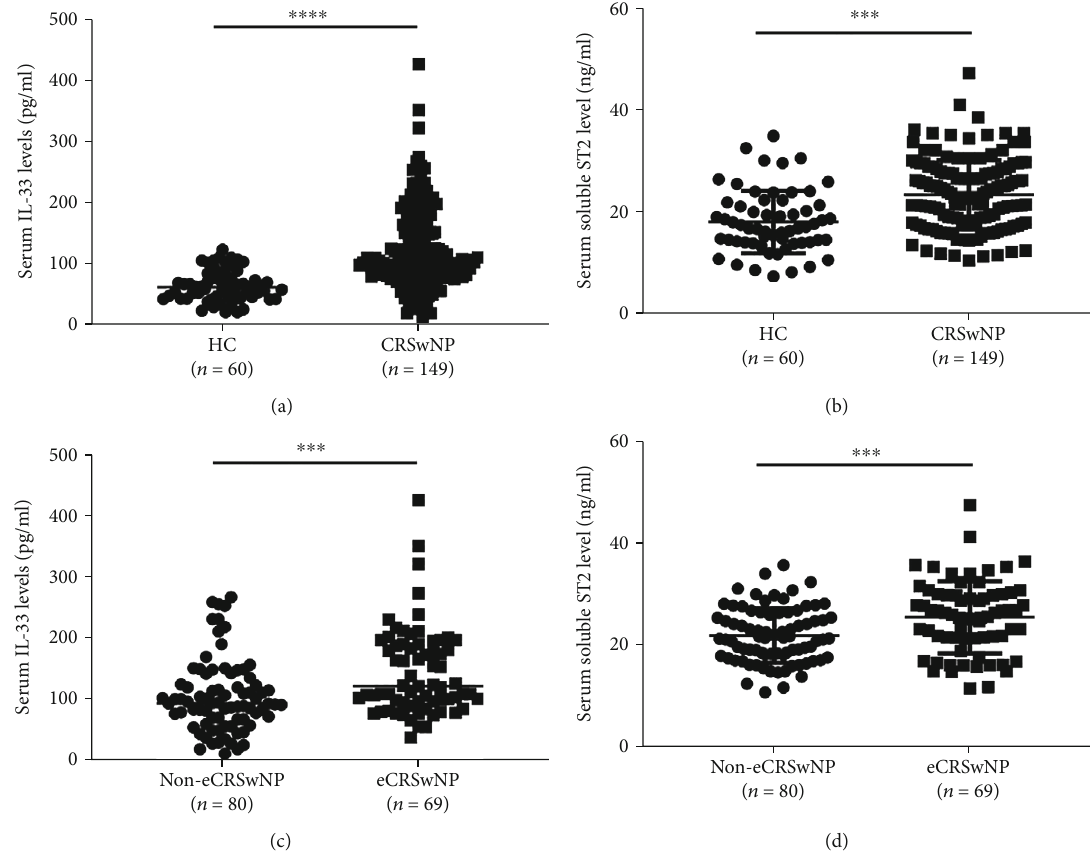
Figure 1: Serum IL-33 and sST2 concentrations were elevated in CRSwNP patients. (a) Serum IL-33 levels and (b) serum sST2 levels were signi fi cantly increased in the CRSwNP group as compared to HCs. Compared with the neCRSwNP group, (c) serum IL-33 and (d) serum sST2 levels were signi fi cantly higher in the eCRSwNP group. ∗∗∗ P < 0 : 001 ; ∗∗∗∗ P < 0 : 0001 . IL-33: interleukin-33; sST2: soluble suppressor of tumorigenicity 2; CRSwNP: chronic rhinosinusitis with nasal polyps; HC: healthy control; neCRSwNP: noneosinophilic chronic rhinosinusitis with nasal polyps; eCRSwNP: eosinophilic chronic rhinosinusitis with nasal polyps. Table 3: Association between serum IL-33 and ST2 levels and clinical parameters in CRSwNP patients.